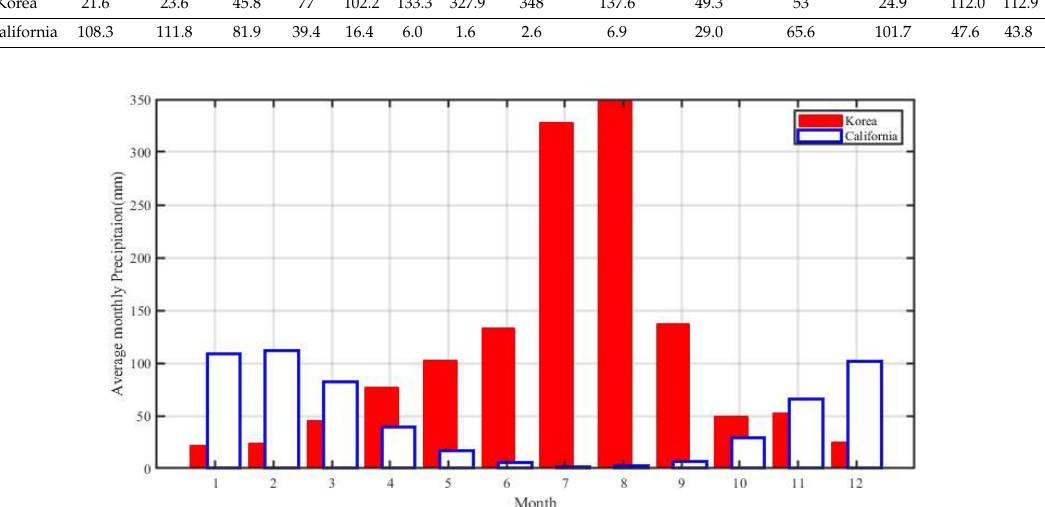
Figure 10. Comparison of monthly mean precipitation in Korea and California [32].